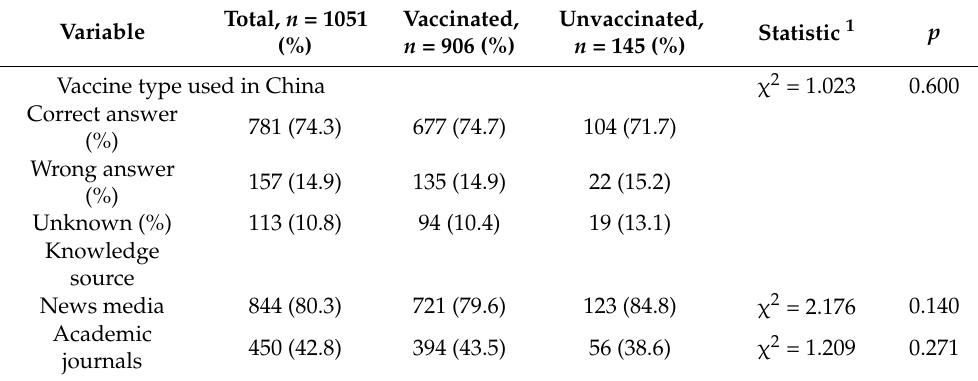
Table 2. Participants’ knowledge of and attitudes to COVID-19